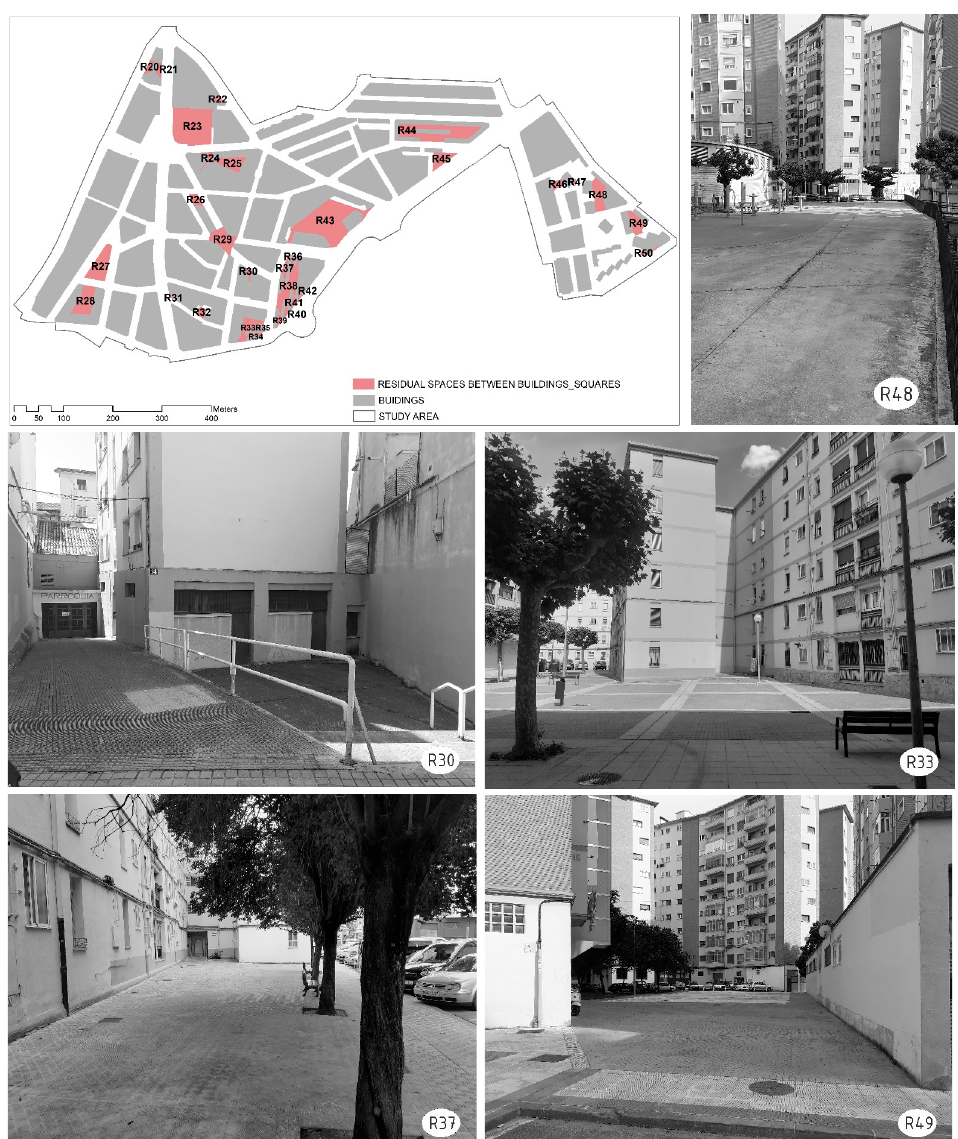
Figure 16. Residual spaces between buildings: squares.